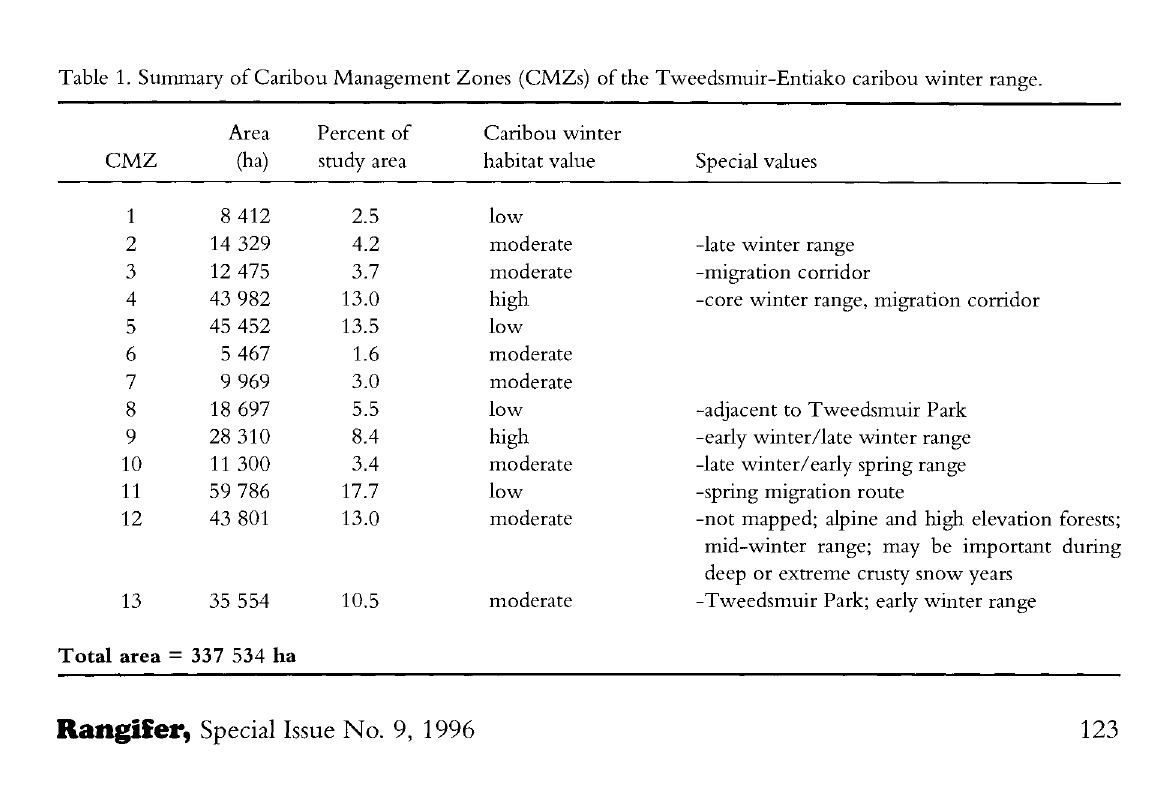
Table 1. Summary of Caribou Management Zones (CMZs) of the Tweedsmuir-Entiako caribou winter range.